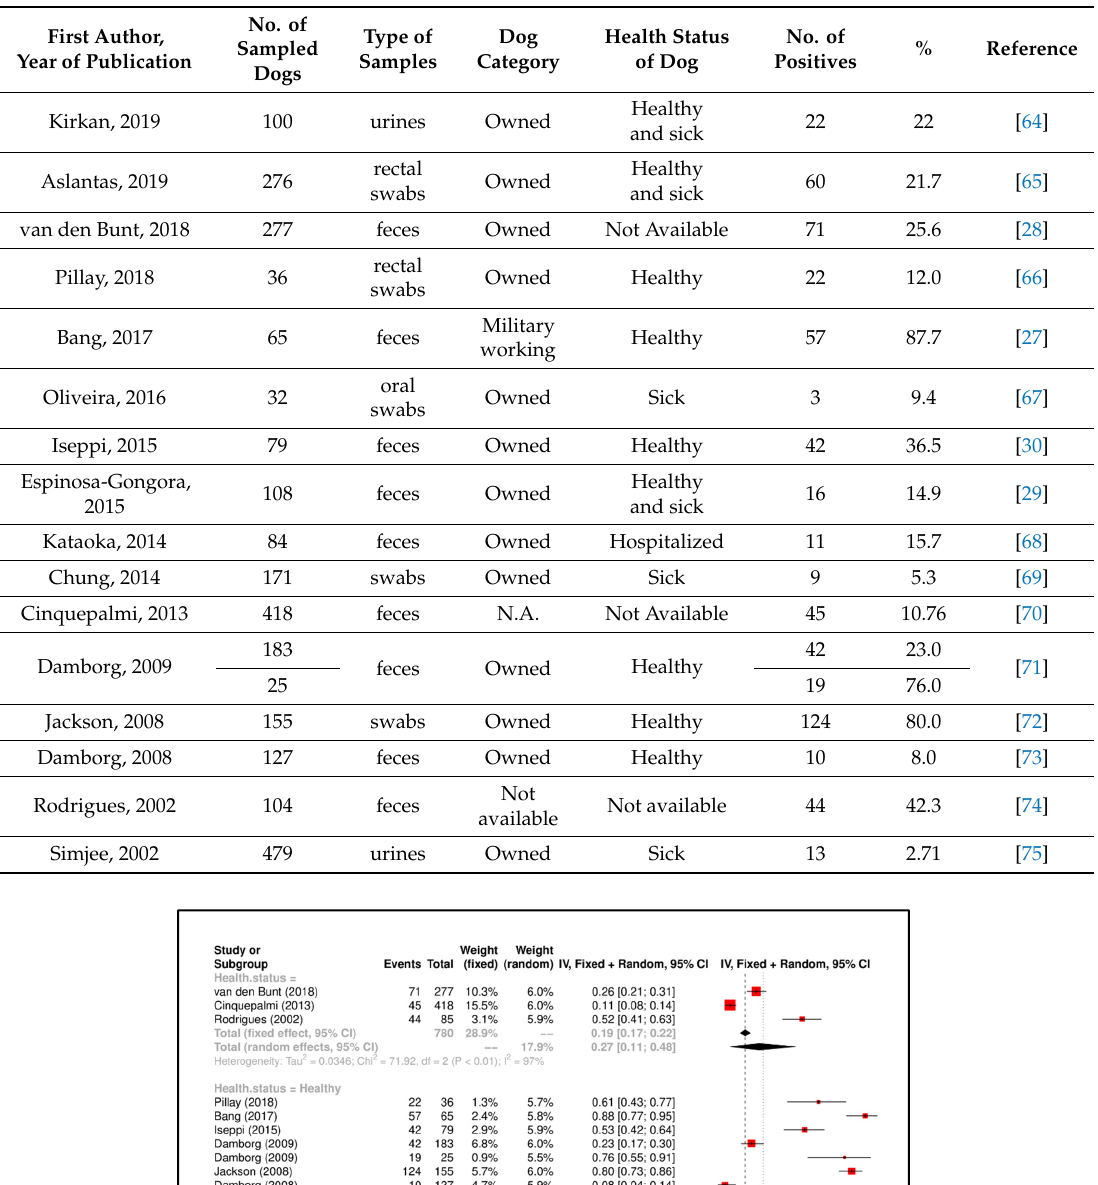
Table 2. Data of the included articles regarding the presence of Enterococcus faecium dogs.